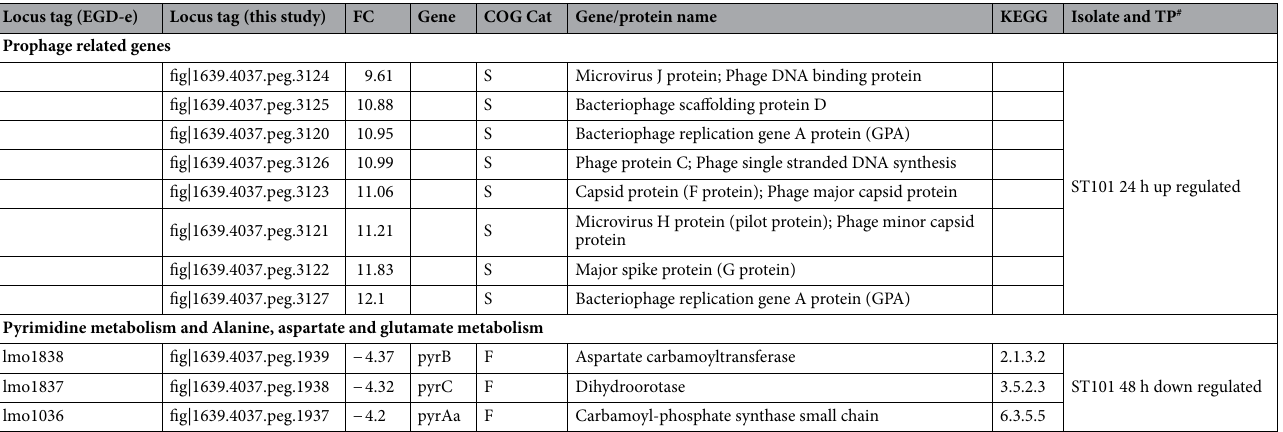
Table 3. ST101 pathways overexpressed in differentially* expressed genes at 24 and 48 h in L. monocytogenes . *FDR < 0.01 log2 fold change. # Time point.